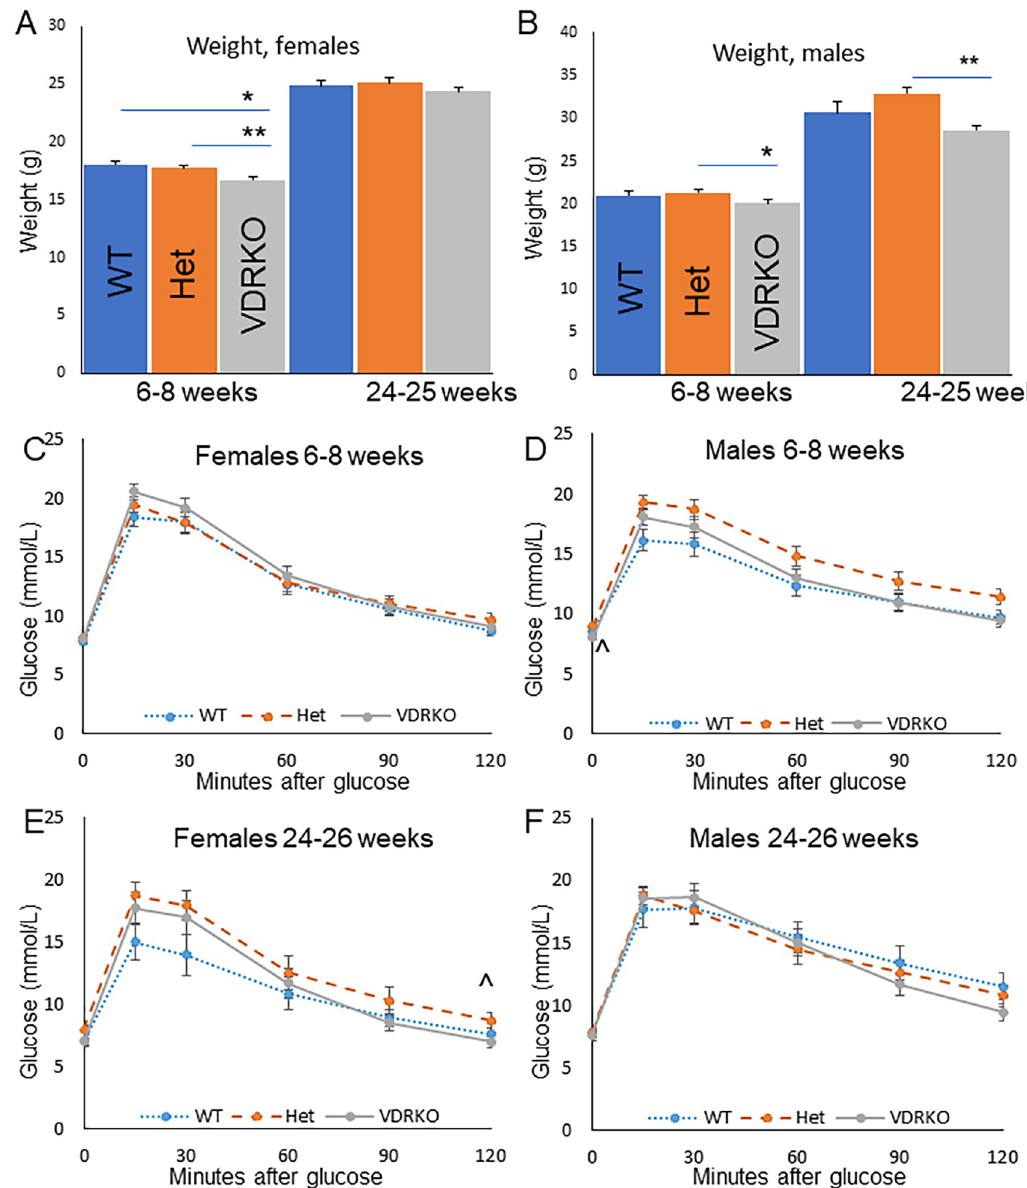
Fig 1. Weight and glucose tolerance in mice eating rescue diet. A) Body weight in female mice. B) Body weight in male mice. C) Glucose tolerance in Females at 6–8 weeks, D) Glucose tolerance in male mice at 6–8 weeks. E) glucose tolerance in older female mice. F) glucose tolerance in older male mice. For young females, N = 34 WT, N = 51 Het, N = 53 VDRKO. For young males, N = 32, 42 and 43. For older females and males N = 15 WT, 22 hets and 23 VDRKO per gender. � p < 0.05 �� p < 0.01, ��� p < 0.001 for VDRKO versus WT. ^ p < 0.05 Het versus VDRKO. Data shows mean ± SEM, p-values corrected for multiple